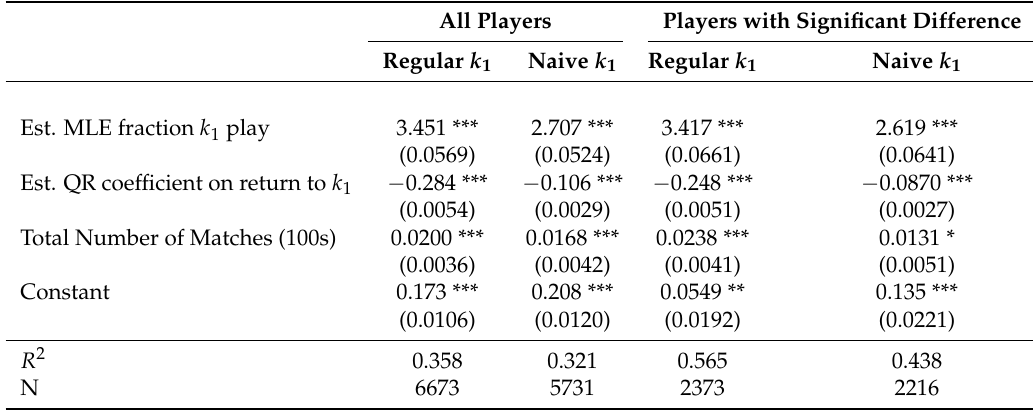
Table 13. Effect of Players’ Parameters on Preferred